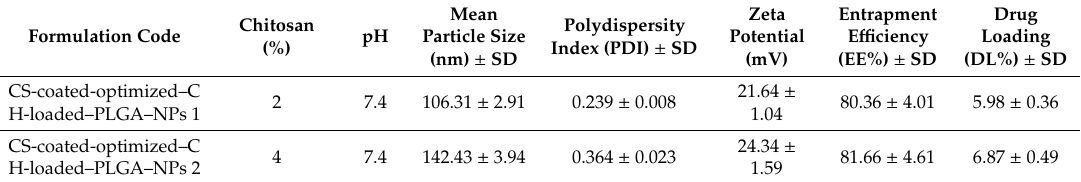
Table 5. Chitosan coating above selected optimized CH-loaded–PLGA–NPs tried 1% and 2% CS